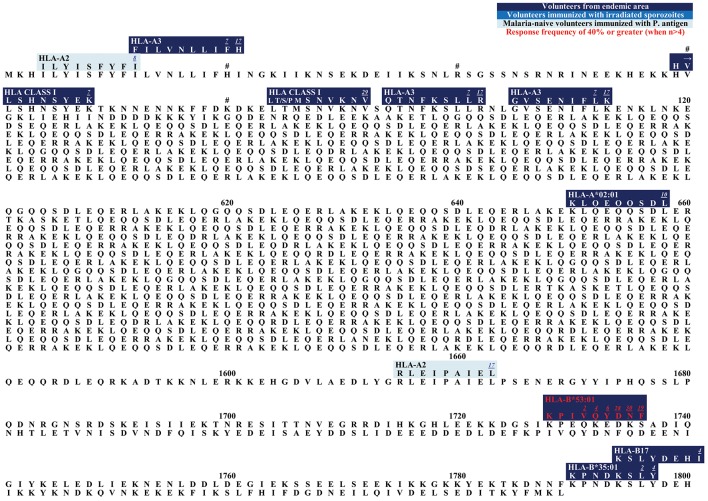
Epitope map of LSA1.